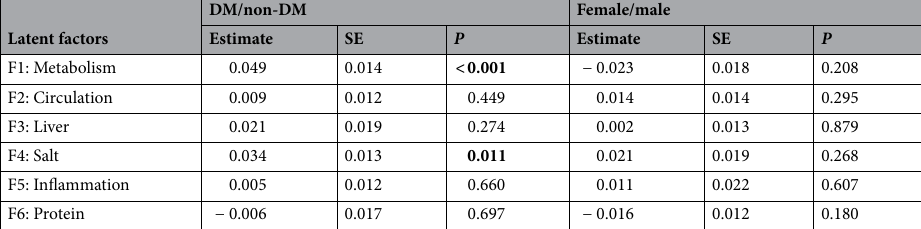
Table 5. Differences in factor means between diabetic and non-diabetic groups and between female and male groups. Significant values are in bold. Factor means were compared in a strict invariance CFA model between diabetes/non-diabetes and in a scalar invariance CFA model between genders. The non-diabetic group and the male group were used as the reference for comparison, and their factor means were fixed at zero. SE standard